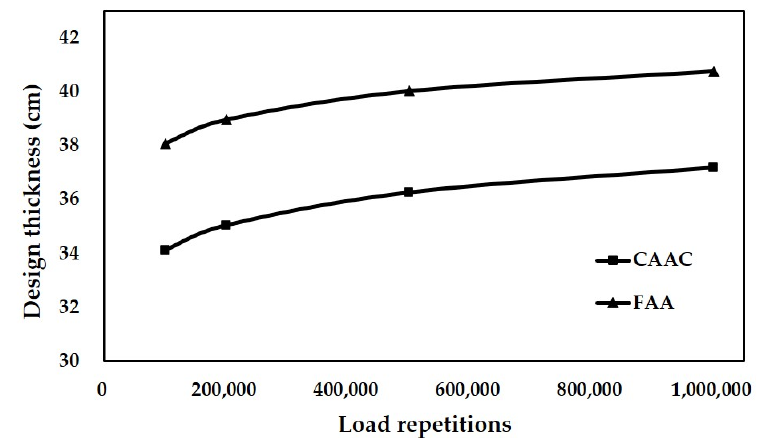
Figure 8. Designed thickness variation of concrete slabs with load repetitions.